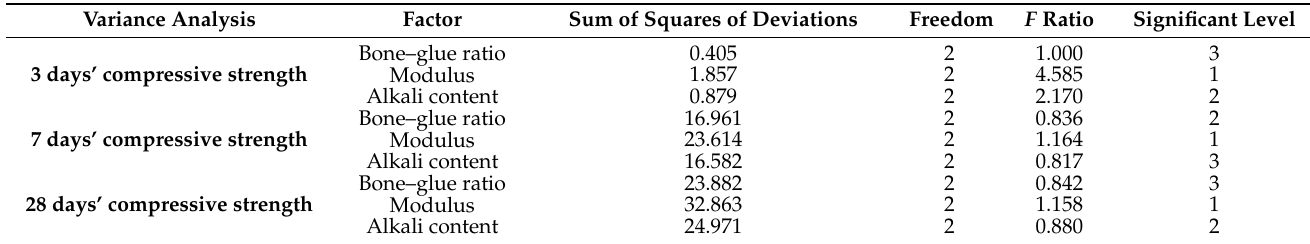
Table 8. Table of variance analysis of compressive strength.